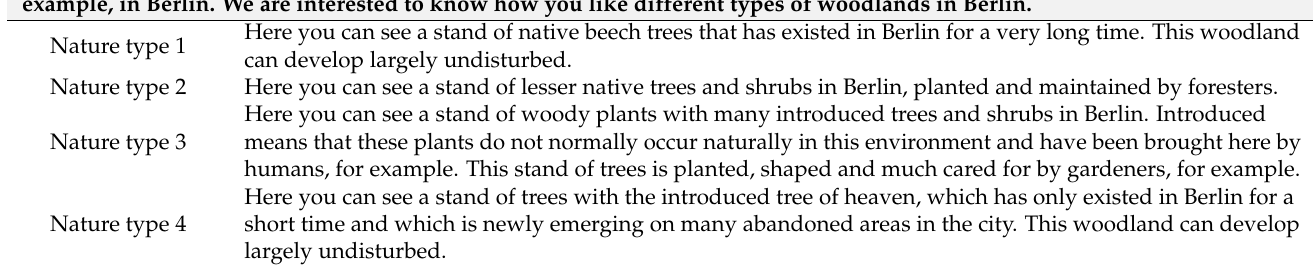
Table A1. Items measured in the questionnaire that are part of this manuscript. While other items were measured in addition, they are not part of the analyses in this manuscript. The questionnaire was conducted in German and has been translated for this